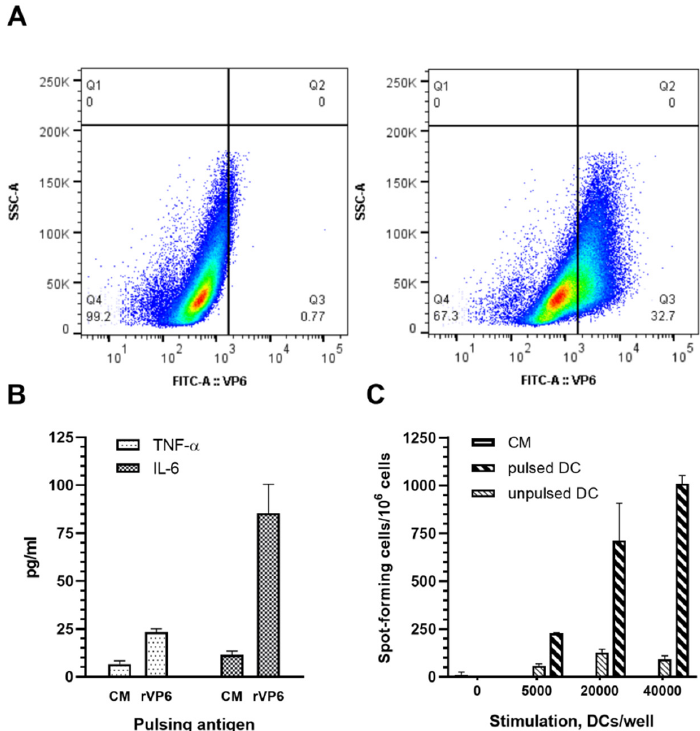
Figure 7. Rotavirus (RV) VP6 internalization, activation and presentation by bone-marrow-derived dendritic cells (BMDCs). Mouse BMDCs incubated for 20 h in the presence of ( A, left panel ) 100 µ g / mL RV VP6 were intracellularly stained for RV VP6 and uptake of VP6 was analyzed by flow cytometry. BMDCs incubated in ( A, right panel ) culture media (CM) only served as negative controls. Uptake of VP6 is shown in the SSC-A versus VP6-FITC density dot plot on BMDCs gated on viable cells, a representative of repeated experiments. ( B ) TNF- α and IL-6 cytokines secretion by BMDC in response to VP6 was measured from CM collected at the end of the incubation period using ELISA. Shown are mean values (pg / mL) of the repeated analysis with standard errors of the mean. ( C ) VP6-pulsed BMDC were used at three di ff erent concentrations to stimulate VP6-specific mouse splenocytes in ELISPOT IFN- γ assay. Results are expressed as the mean spot forming cells (SFC) per 10 6 splenocytes of the duplicate wells with standard errors of the mean.